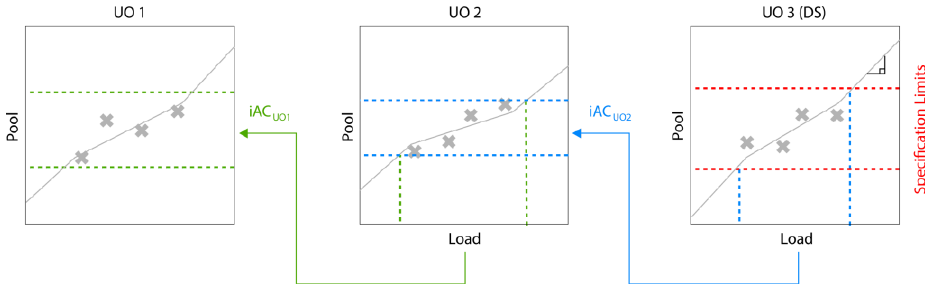
Figure 3. Inverse iAC calculation, beginning with drug specifications at the last UO.